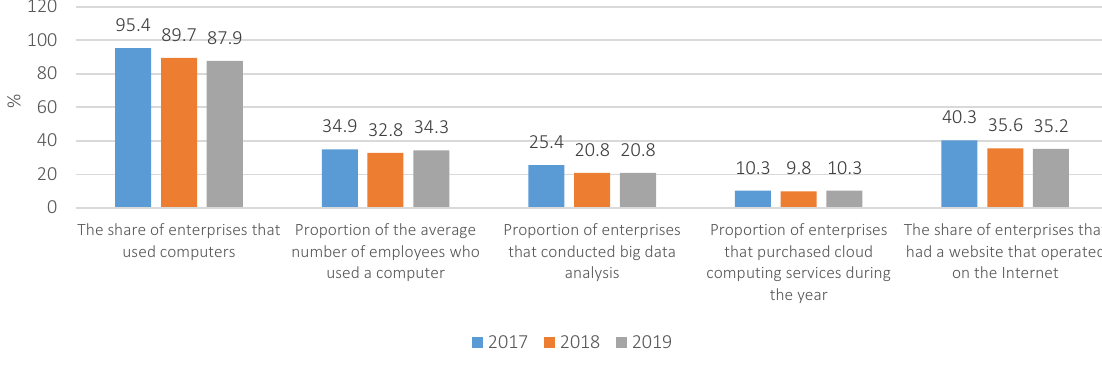
Figure 2. Dynamics of indicators of informatization of enterprises and organizations of